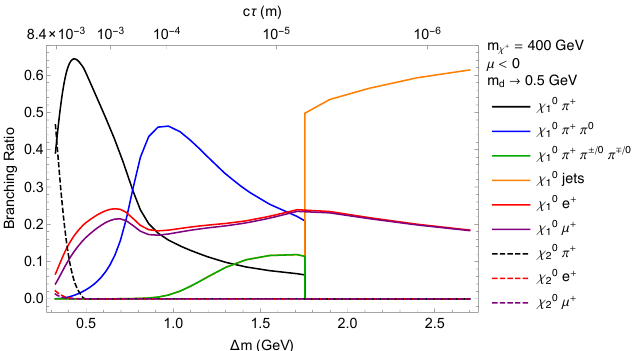
Figure 2 . Decay branching ratios for a 400 GeV charged Higgsino as a function of (cid:1) m = m and (cid:22) < 0. Note the chargino lifetime on the upper vertical axis. Hadronic decay widths are computed assuming m d = 0 : 5 GeV. The switch from an exclusive hadronic (cid:12)nal state description to an inclusive jet (cid:12)nal state description occurs at around (cid:1) m 1.3 GeV if the assumed m D is taken to zero. The (cid:22) > 0 case is qualitatively very similar, and there is very little dependence on the Higgsino